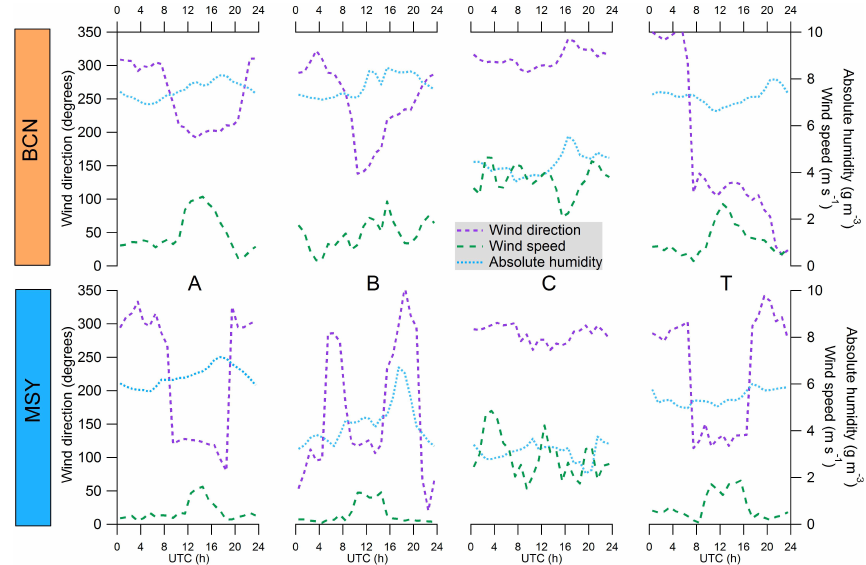
Fig. 4. Average wind direction and speed, and average absolute humidity for each atmospheric scenario at BCN (top panels) and MSY (bottom panels).